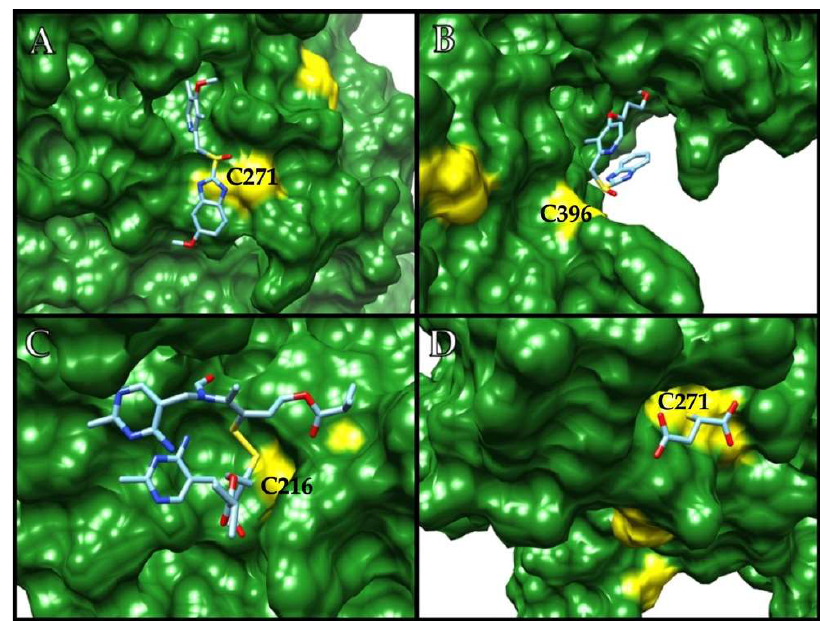
Figure 2. Representative docking of GlADI with ( A ) omeprazole, ( B ) rabeprazole, ( C ) sulbutiamine, and ( D ) aurothiomalate. Cysteine residues near the binding sites are yellow-colored. Cysteine residues interacting with each of the molecules are indicated in bold type.